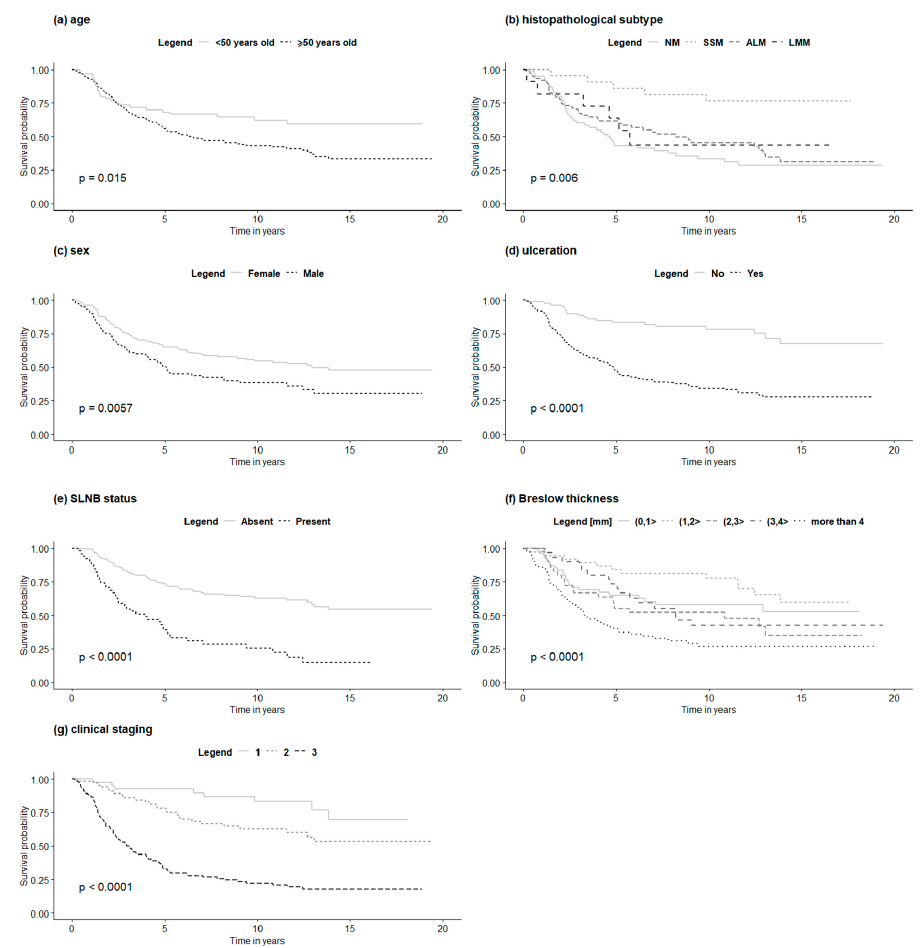
Figure 2. OS in HFM patients according to clinicopathological features: ( a )—age, ( b )—